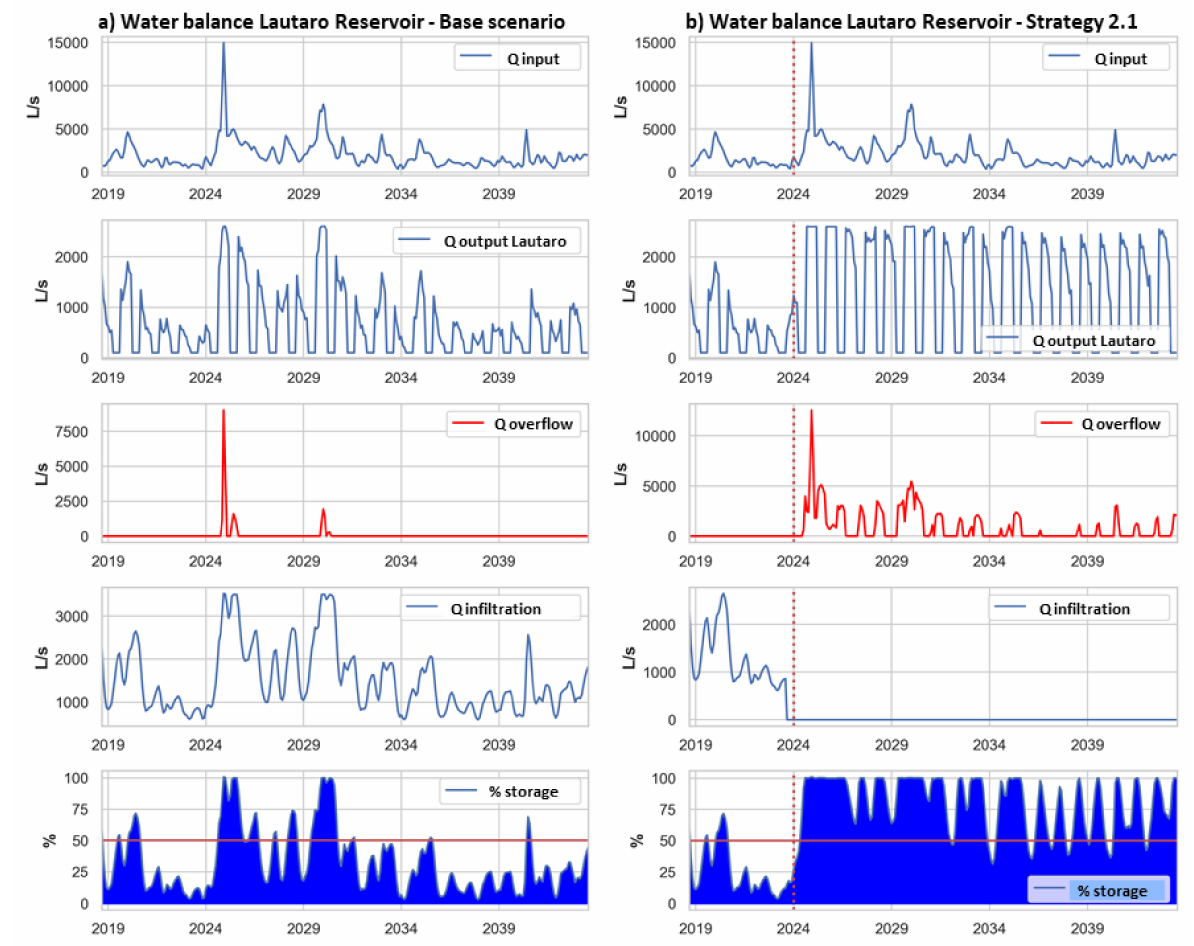
Figure 9. Water balance for the Lautaro Reservoir for ( a ) base scenario and ( b ) strategy 2.1, reflecting